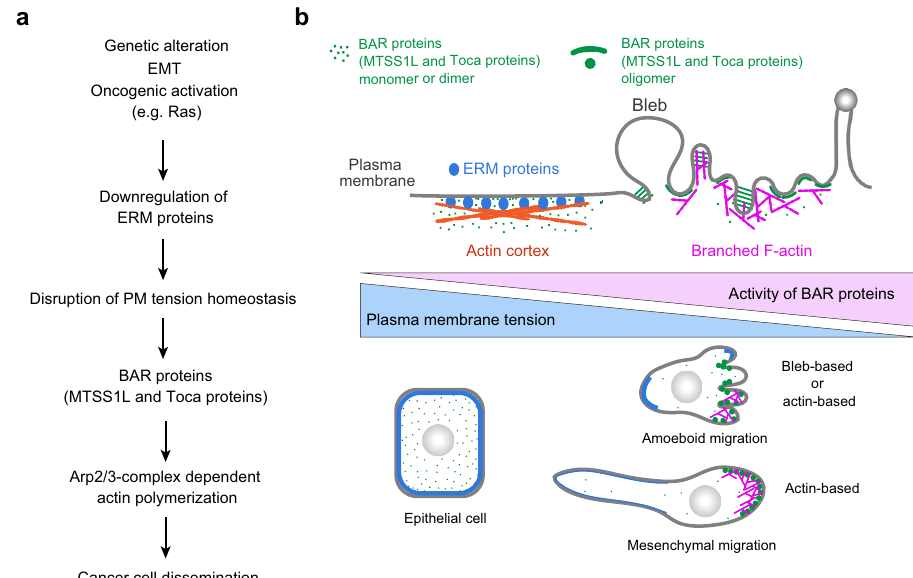
Fig. 6 Proposed model describing how homeostatic PM tension acts as the mechanical suppressor of cancer cell dissemination. a Proposed model to describe how cancer progression is linked to the disruption of homeostatic PM tension, leading to cancer cell dissemination via BAR proteins. b Homeostatic PM tension sustained by membrane-to-cortex attachment (MCA) can maintain a non-motile state by suppressing the assembly of BAR proteins, key regulators of both actin- and bleb-based